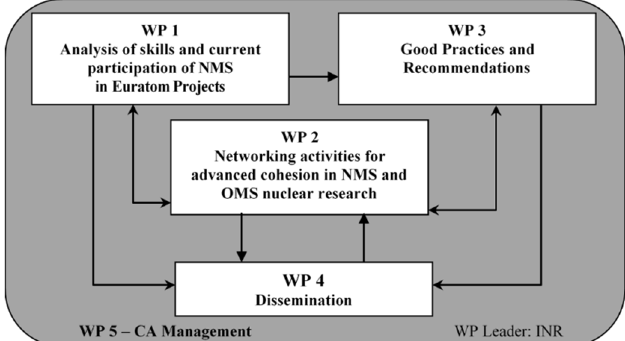
Fig. 1. Functional sketch of the